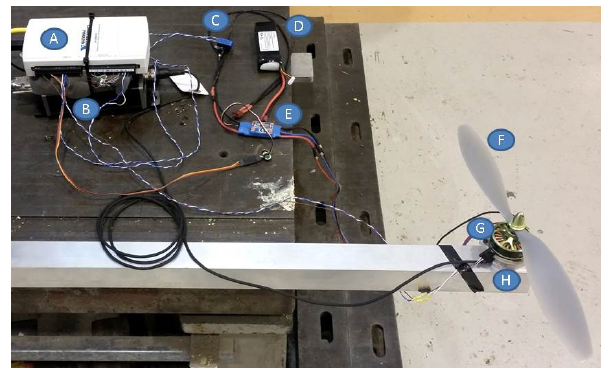
Figure 4: Experimental setup for validation. A: Digi-